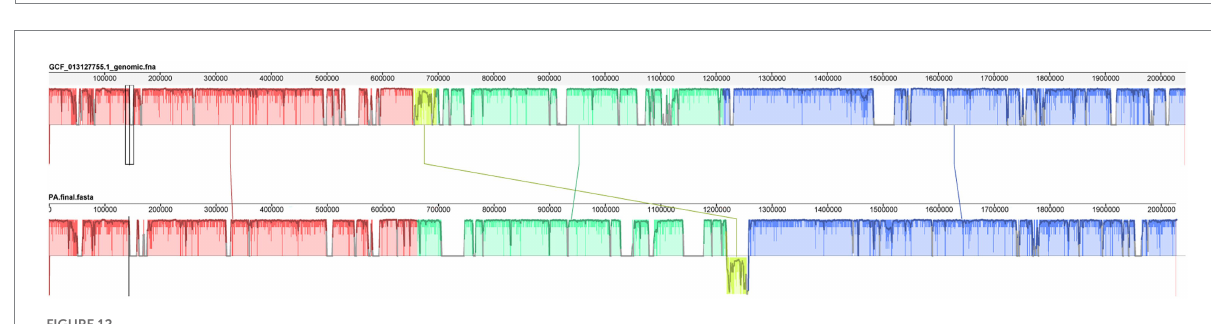
FIGURE 11 Nucleotide levels were compared between two genomic relatedness.